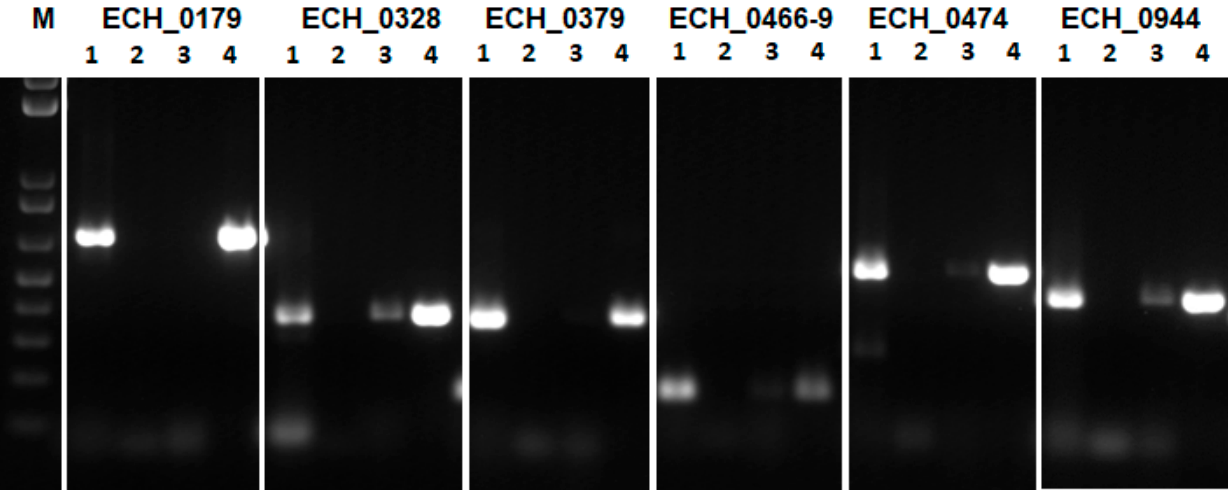
Figure 3. E. chaffeensis antiporter gene transcripts assessed by RT-PCR for the respective gene recombinant plasmids transformed into the E. coli strain EP432. The assays for each gene included four reactions: 1, RNA sample with reverse transcriptase and Taq polymerase; 2, nuclease-free water with reverse transcriptase and Taq polymerase (to serve as the negative control); 3, RNA template with Taq polymerase and without reverse transcriptase (to serve as the negative control and to eliminate false positives resulting from the residual DNA contamination; 4, E. chaffeensis genomic DNA with Taq polymerase (to serve as the positive control). (Note; weaker amplicons found in lane 3 for ECH_0328, ECH_0466-9, ECH_0474 and ECH_0944 represent the incomplete elimination of DNA contamination.)